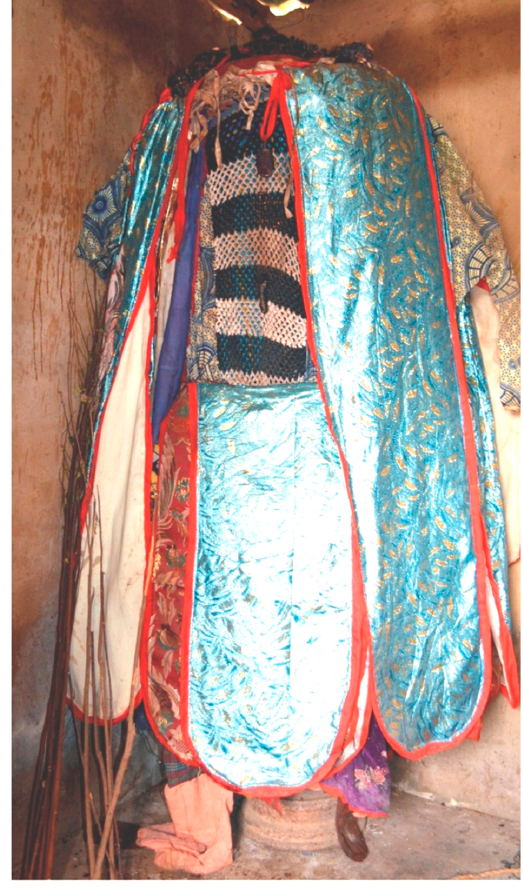
Figure 7. Èkú of egúngún Je ń jù . Source: Photograph by author. Figure 7. È k ú of eg ú ng ú n Je´nj ù . Source: Photograph by